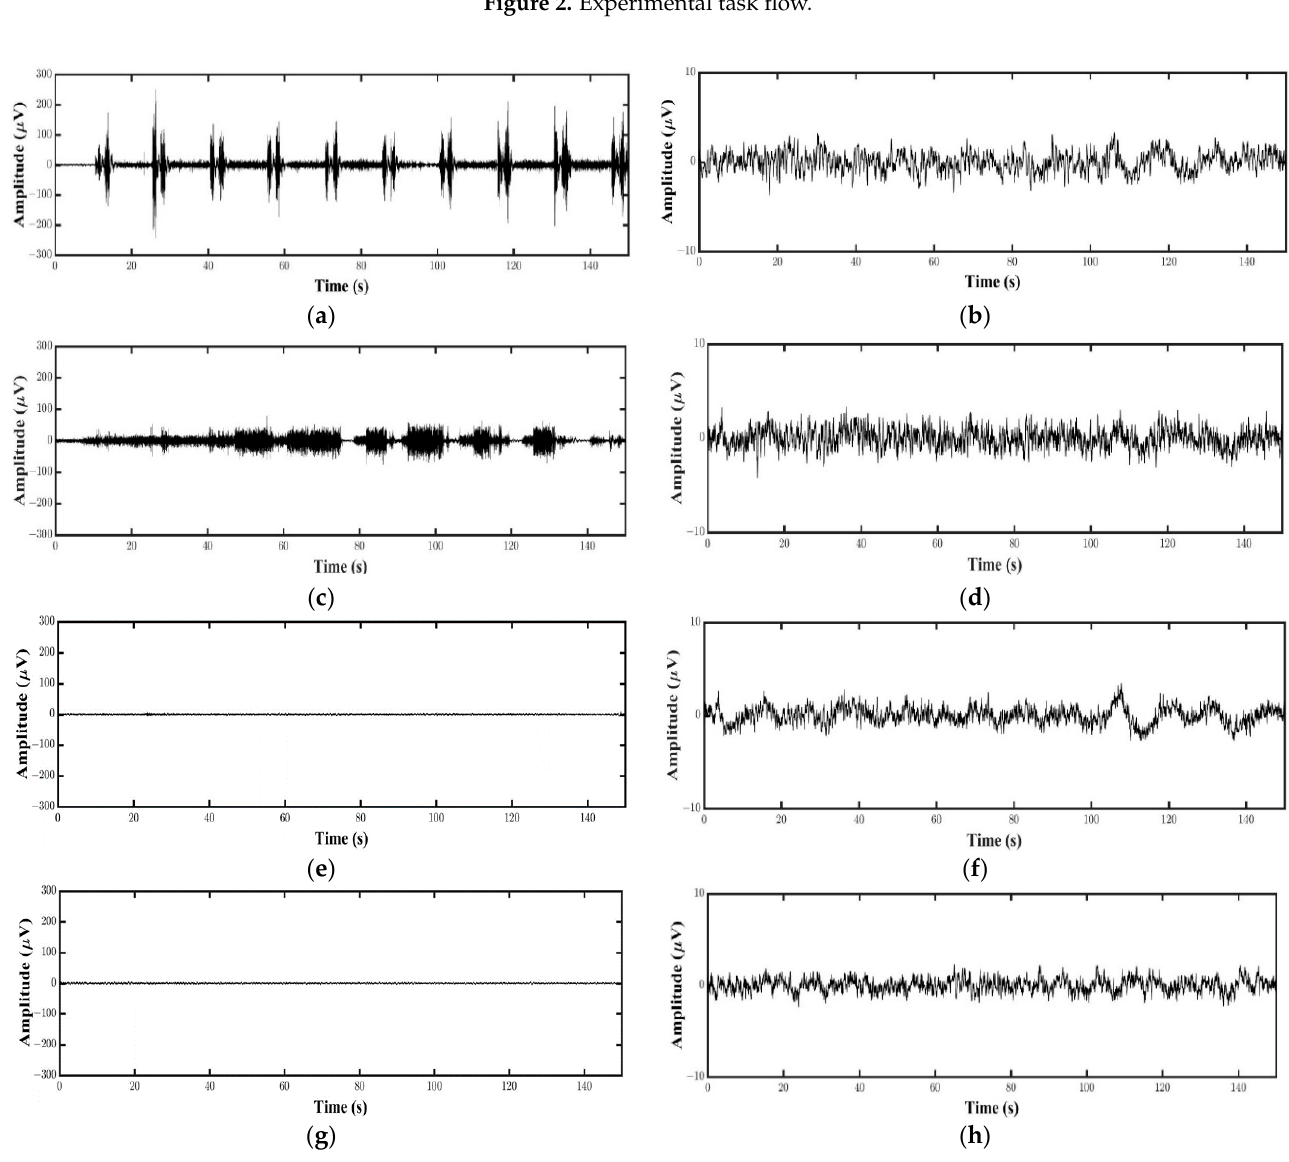
Figure 3. Ten trials of one subject’s EEG and EMG data: ( a ) EMG data in RM task; ( b ) EEG data in RM task; ( c ) EMG data in Inten task; ( d ) EEG data in Inten task; ( e ) EMG data in MI task; ( f ) EEG data in MI task; ( g ) EMG data in OL task; ( h ) EEG data in OL task.